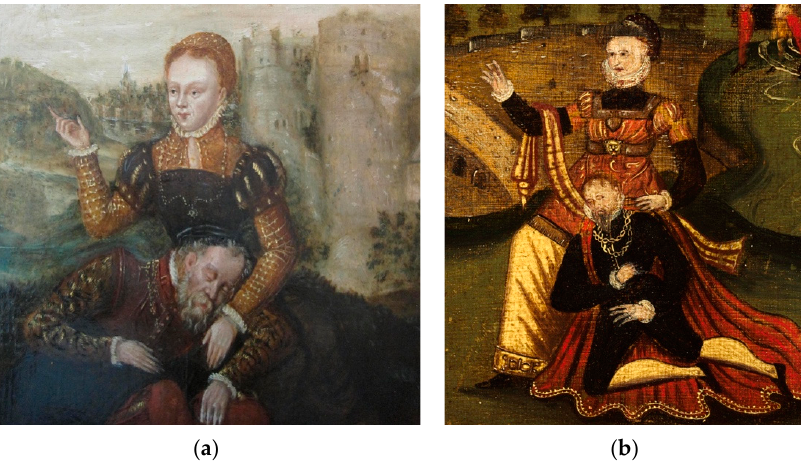
Figure 17. ( a ) Detail of the fair Lady and the ancient knight in the Riddle ‘dyvoted ‘ to William Cecil, Hatfield House, Hertfordshire, UK, courtesy of the Marquess of Salisbury; ( b ) Detail of the fair Lady and the ancient knight in Unidentified Artist, ‘The Allegorie of a Faire Ladye’, 1570–1579, oil on panel, Harvard Art Museums/Fogg Museum, Gift of Robert Rantoul Endicott, Photo © President and Fellows of Harvard College, 1959.143, 45.7 cm × 54.3 cm (18 × 21 3/8 in.) Harvard Art Museums collections online, https://hvrd.art/o/228438 (accessed on 5 January